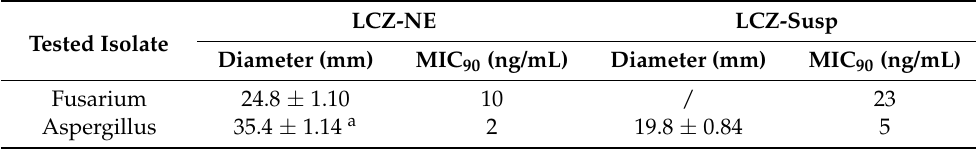
Table 4. Antifungal activity of the LCZ-NE and LCZ-Susp against Fusarium and Aspergillus . Tested